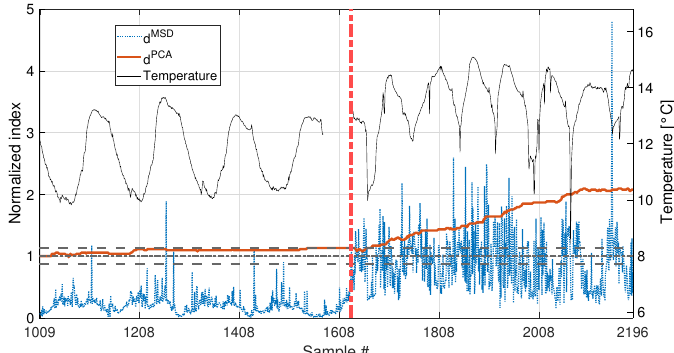
Figure 23. Comparison between d MSD (blue dotted line) and d PCA (red solid line), with b = 1008, for added mass equal to 1% of the total mass. A black thin line identifies the temperature.